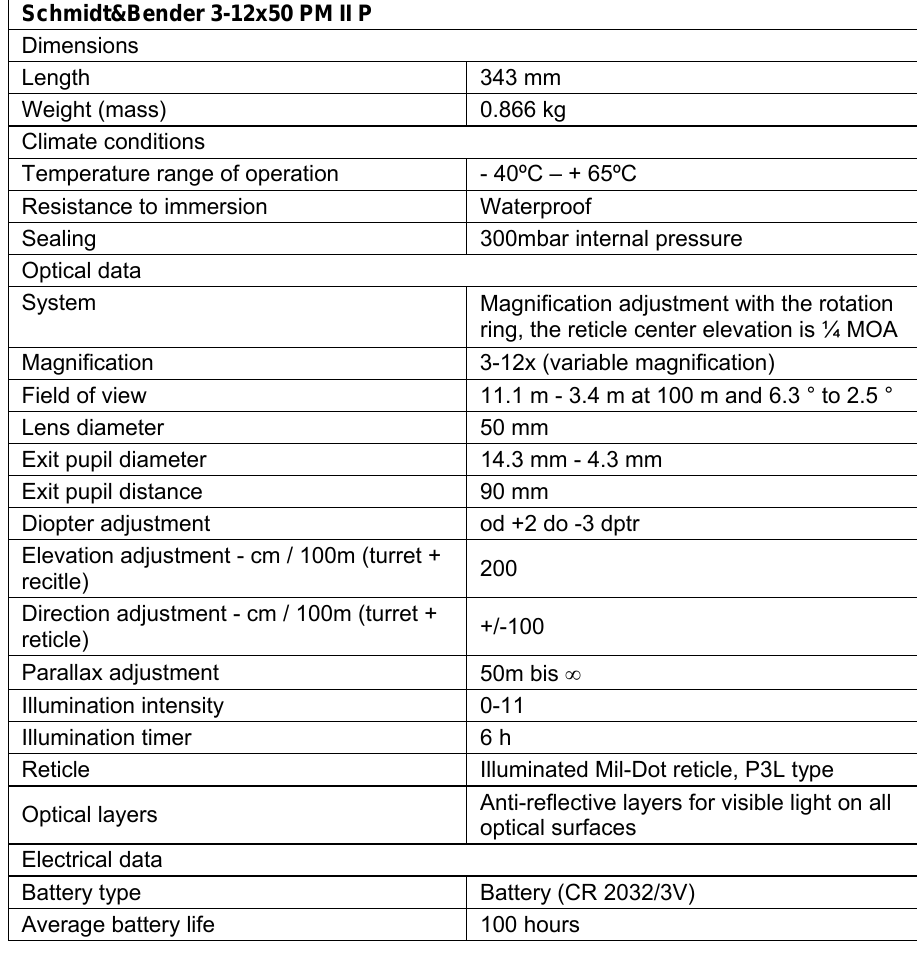
Table 7 – Technical-technological characteristics of the Schmidt & Bender 4-16x50 PM II LP optical sight (Schmidt&Bender, 2016), (Serbian Armed Forces, 2016) Таблица 7 – Технико - технологические характеристики оптического